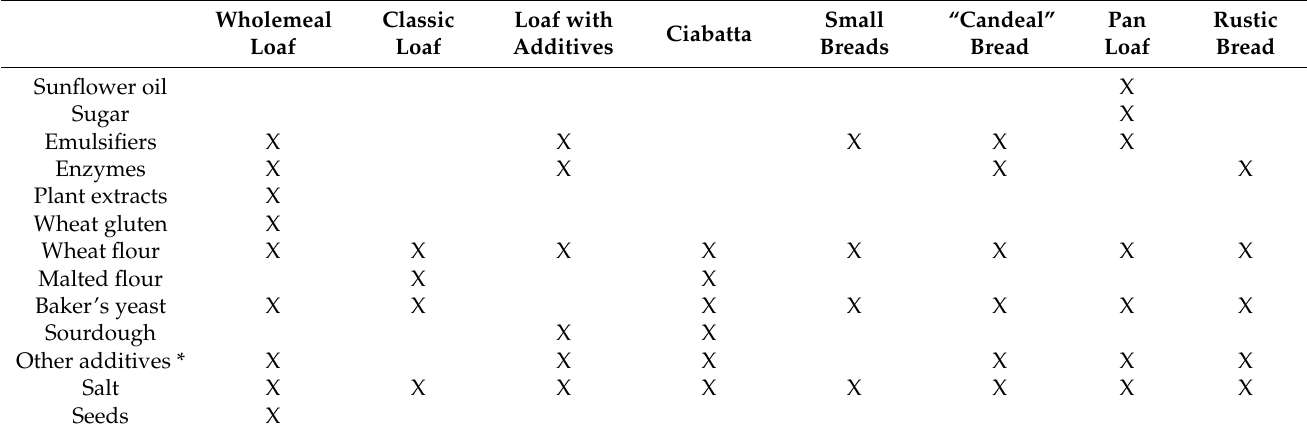
Table 1. Ingredients of the breads